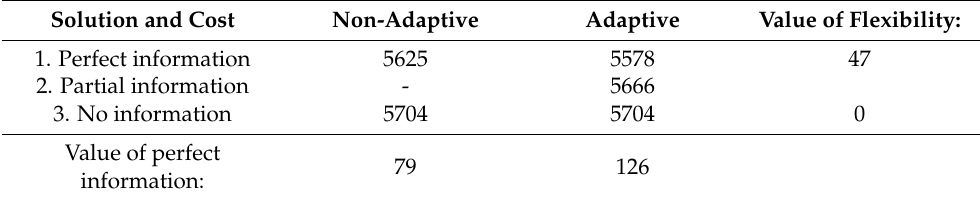
Table 9. Summary of value of information and value of flexibility (in million